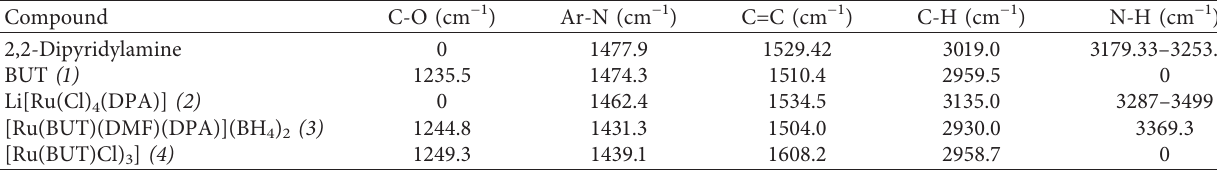
Table 1: Summarized FTIR assignments for ligands and